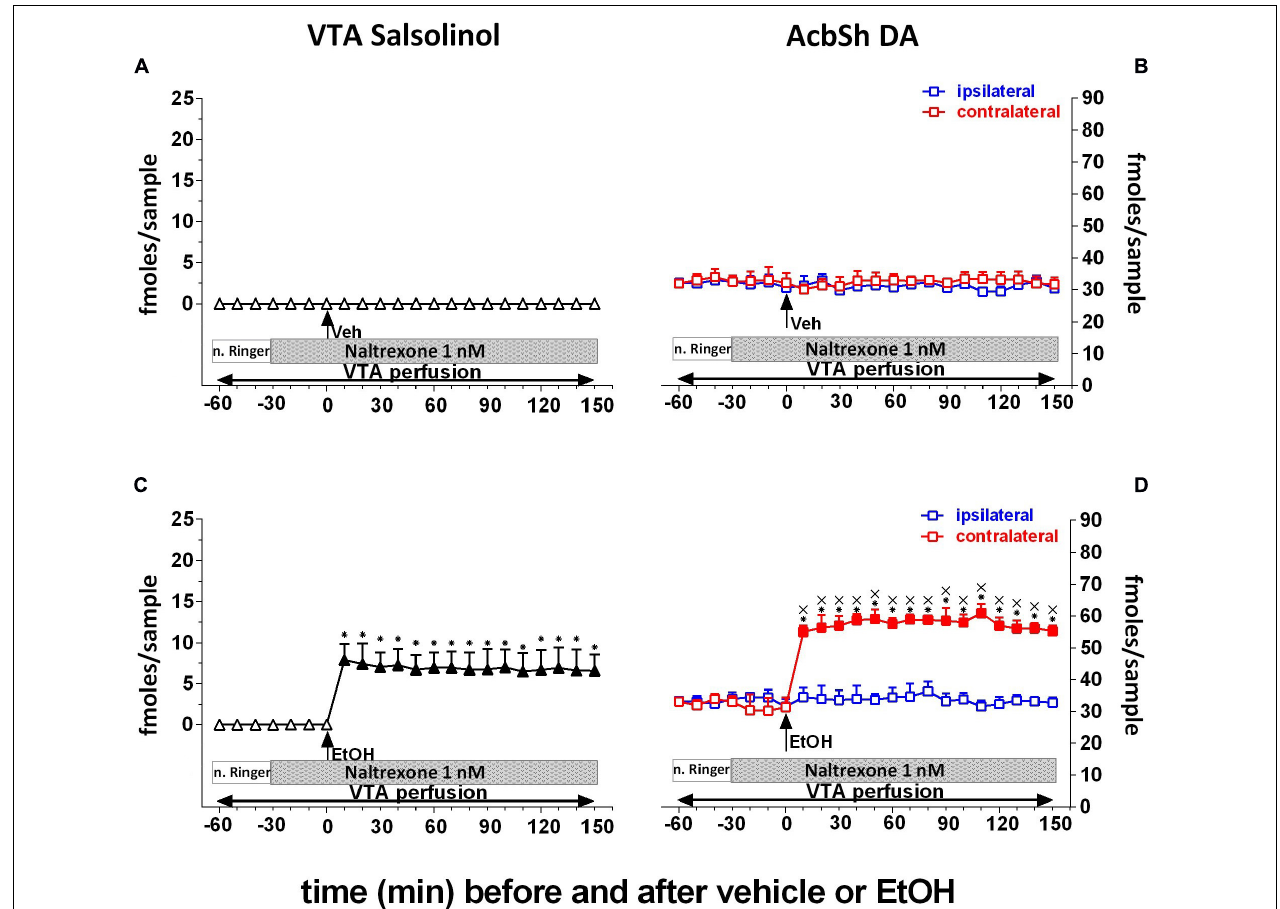
FIGURE 6 | Effects of intragastric administration of vehicle (tap water, 10 ml/kg) [ (A) N = 9, (B) N = 8] or ethanol (EtOH) (1 g/kg, 20% v/v) [ (C) N = 12, (D) N = 11] in the presence of reverse dialysis application in the pVTA, beginning 30 min before EtOH administration, of naltrexone (1 nM) on VTA salsolinol (A,C) and on ipsilateral and contralateral AcbSh DA (B,D) dialysates. Horizontal bars depict the contents of the pVTA perfusion fluid along the experiment. Vertical arrows indicate the last pVTA or AcbSh microdialysis sample before vehicle or EtOH administration. Filled symbols indicate samples representing p < 0.001 vs. basal; * p < 0.01 vs. vehicle administration; x p < 0.01 vs. ipsilateral